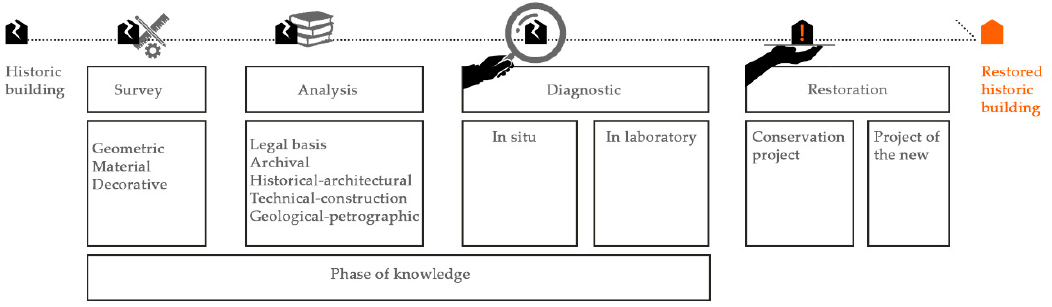
Figure 1. Scheme of the methodological guide proposed for the renovation process of a historic building.